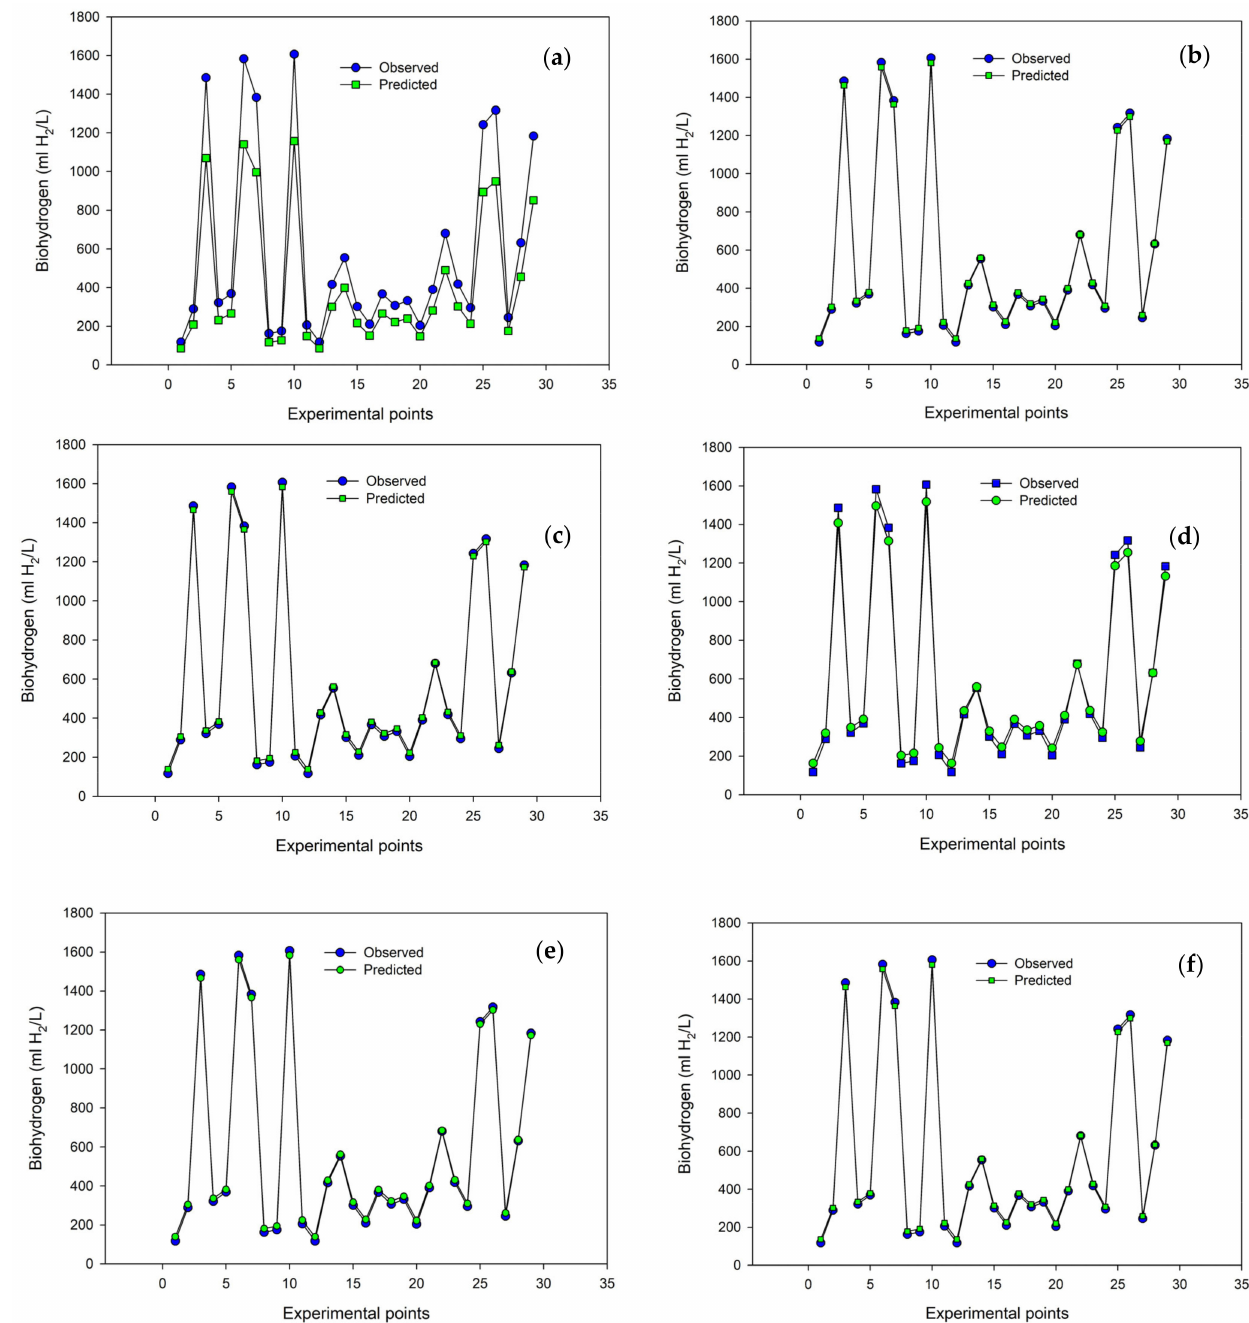
Figure 6. Comparison between actual and predicted biohydrogen using ( a ) MLPNN-7 ( b ) MLPNN-8 ( c ) MLPNN-9 ( d ) MLPNN-10 ( e ) MLPNN-11 ( f ) MLPNN-12 with a gradient descent optimization